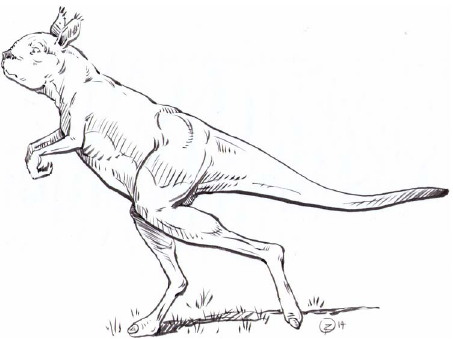
Figure 1. Reconstruction of Sthenurusstirlingi . By Brian Regal.